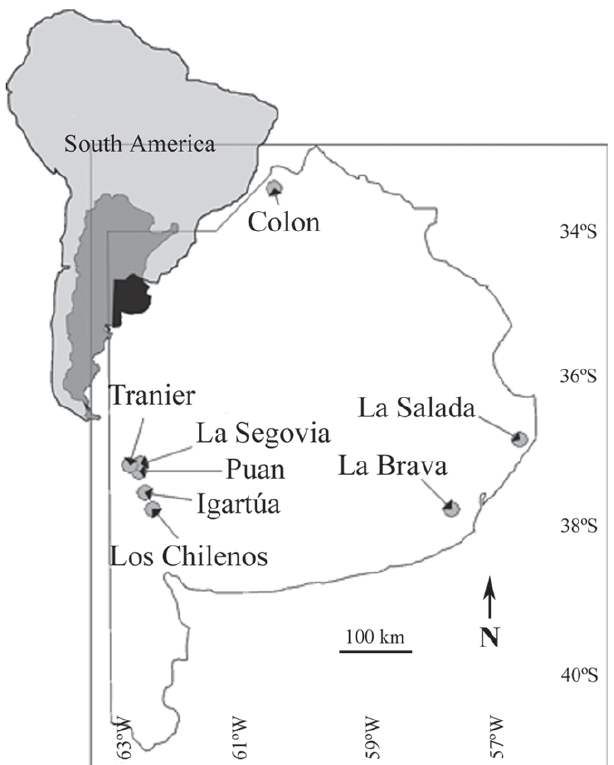
Fig. 1. Geographical location of sampled lakes in the Pampean region